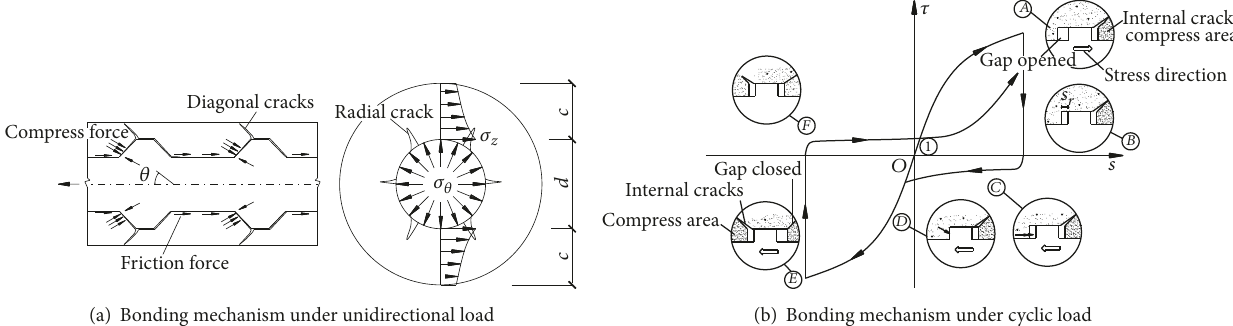
Figure 9: Bonding mechanism of longitudinal steel